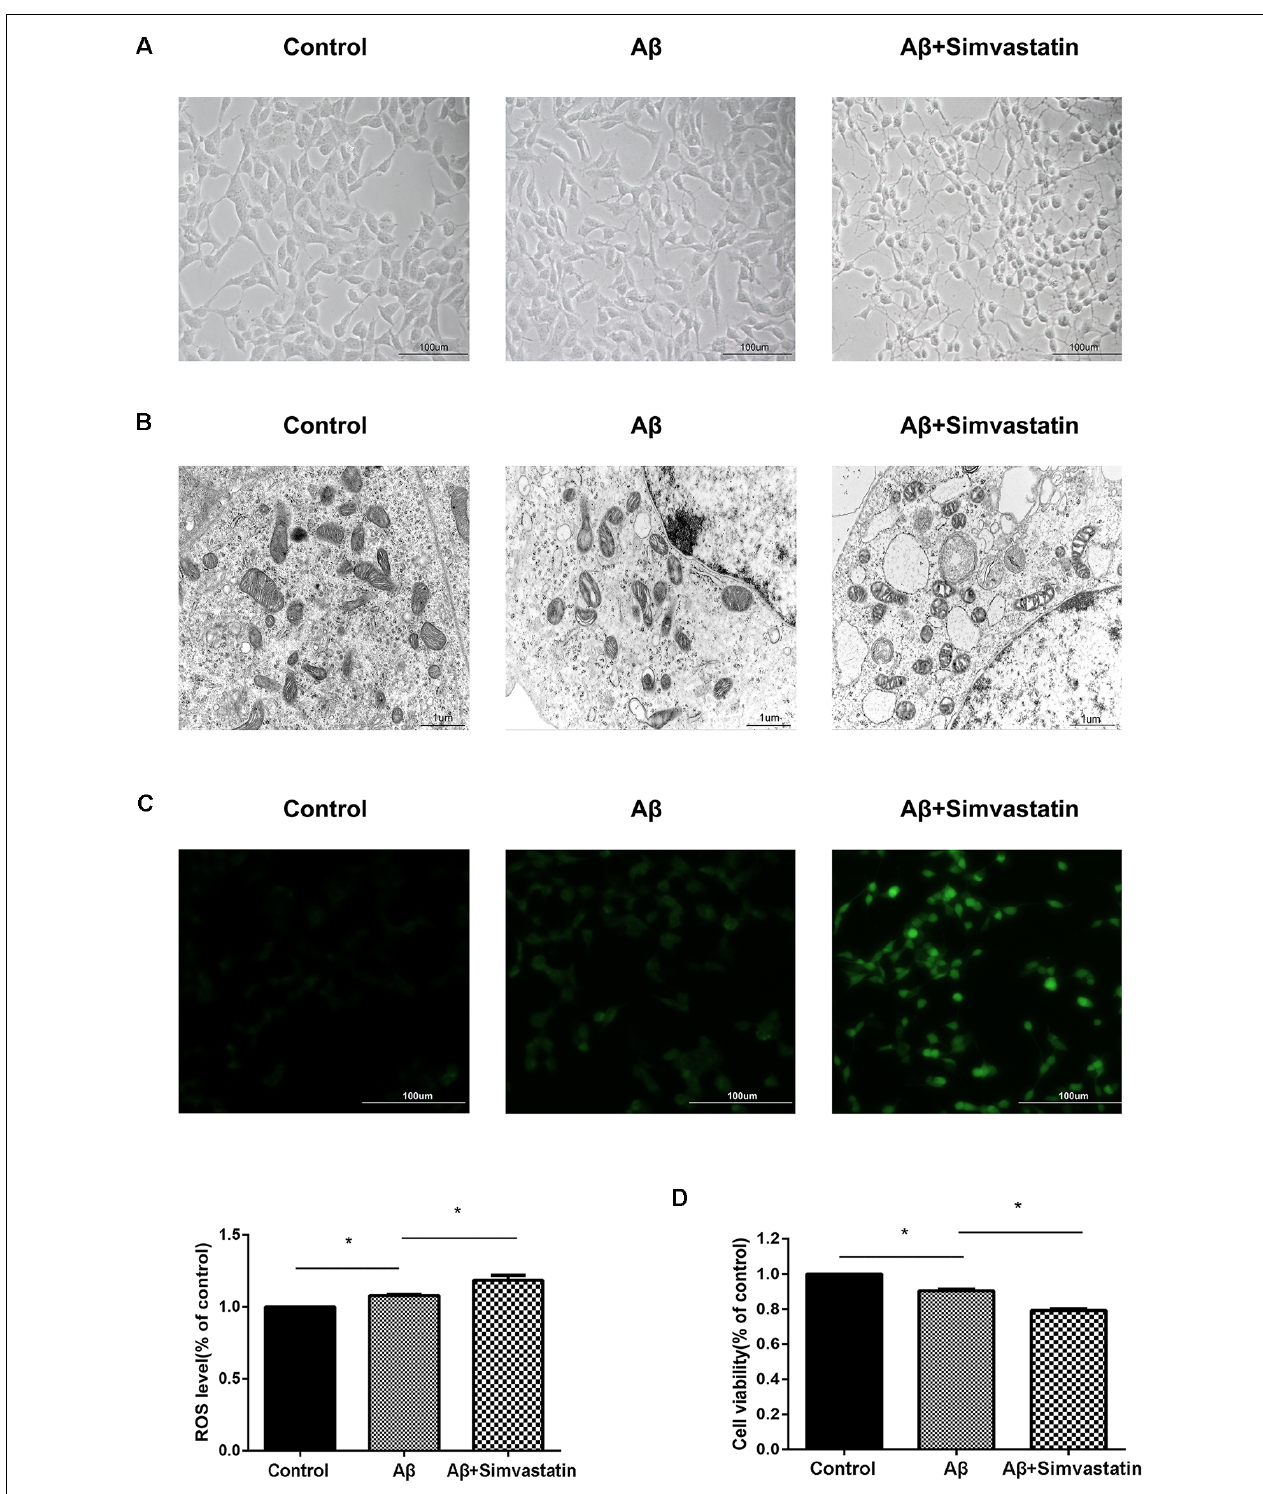
FIGURE 3 | Simvastatin treatment changes the cell morphology and mitochondrial structure, increases the intracellular reactive oxygen species (ROS) level and aggravates the cytotoxic effect of A β 25–35 in SHSY5Y cells. After treated with 10 µ M simvastatin for 24 h and 20 µ M A β 25–35 for 4 h, the morphology of SHSY5Y cells were observed by a light microscope (A) , the mitochondrial structures were observed by an electron microscope (B) , the intracellular ROS level was measured by DCFH (C) , viability of the cells was examined by Cell Counting Kit 8 (CCK8) assay (D) . The data are mean ± SEM ( n = 3, ∗ p < 0.05).